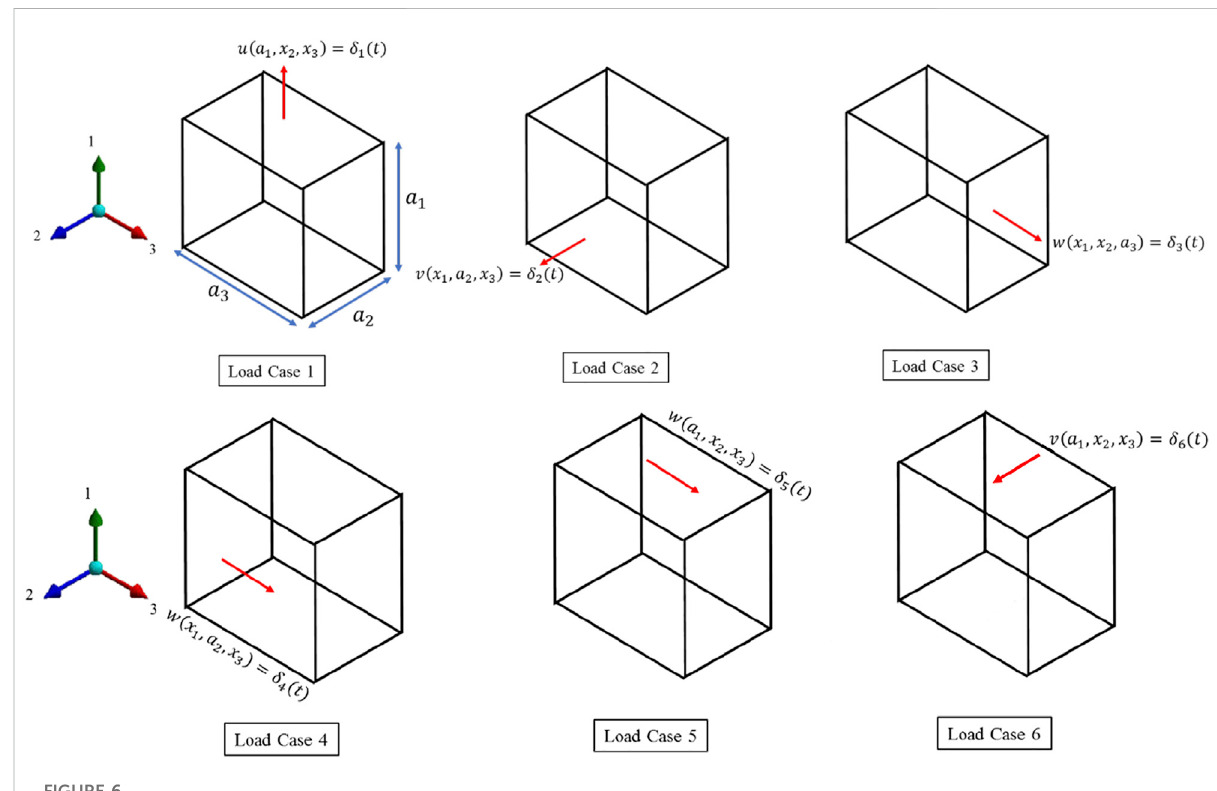
FIGURE 6 6 load cases for the viscoelastic